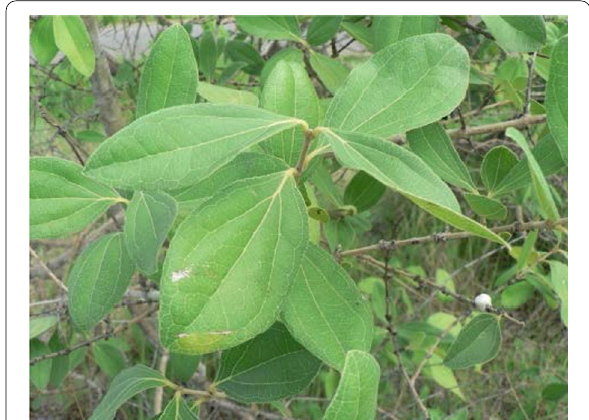
Fig. 1 Strychnos innocua , showing the leaves and branches